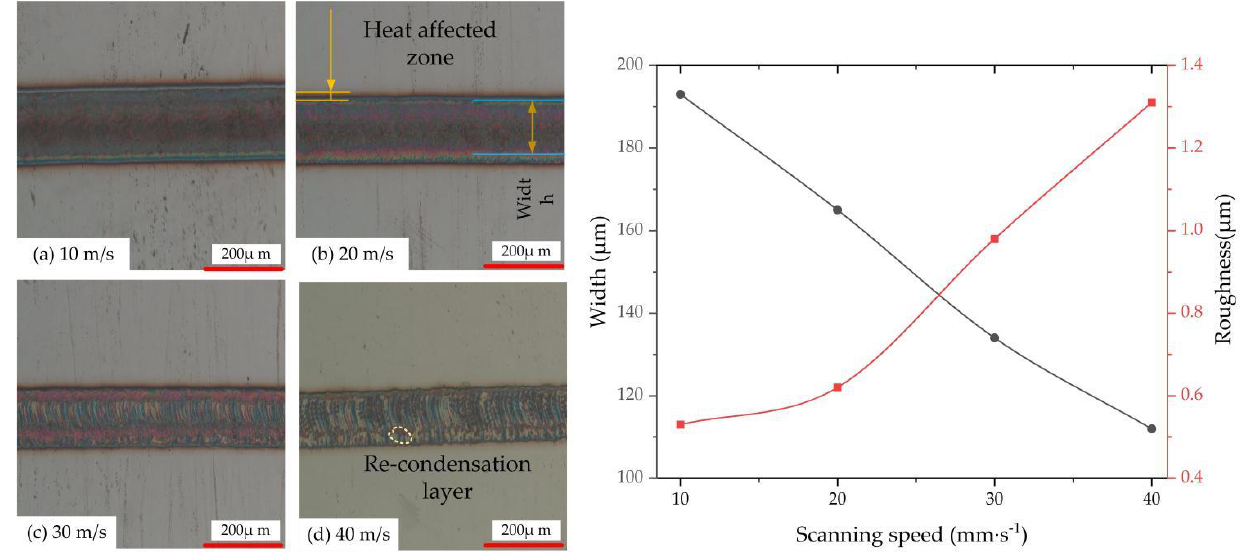
Figure 6. Micro-size changes of stainless steel samples at different scanning speeds, ( a ) 10 m/s; ( b ) 20 m/s; ( c ) 30 m/s; ( d ) 40 m/s. ( b ) 20 m/s; ( c ) 30 m/s; ( d ) 40